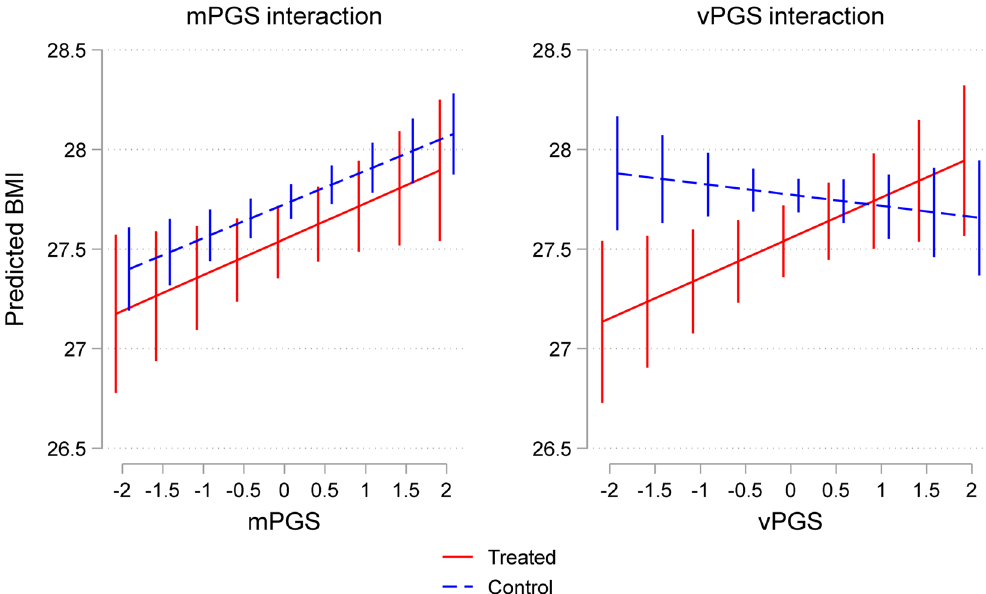
Figure 2. Predicted BMI for treatment and control groups by mPGS and vPGS. The figure depicts the predicted BMI for treatment and control groups using coefficients from the empirical models reported in Table 3 (Column 5) for the mPGS interaction, and Table 3 (Column 6) for the vPGS interaction. Error bars represent 95% confidence intervals.